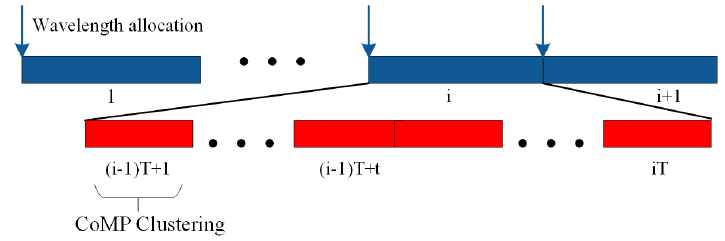
Figure 2. Two-timescale Resource